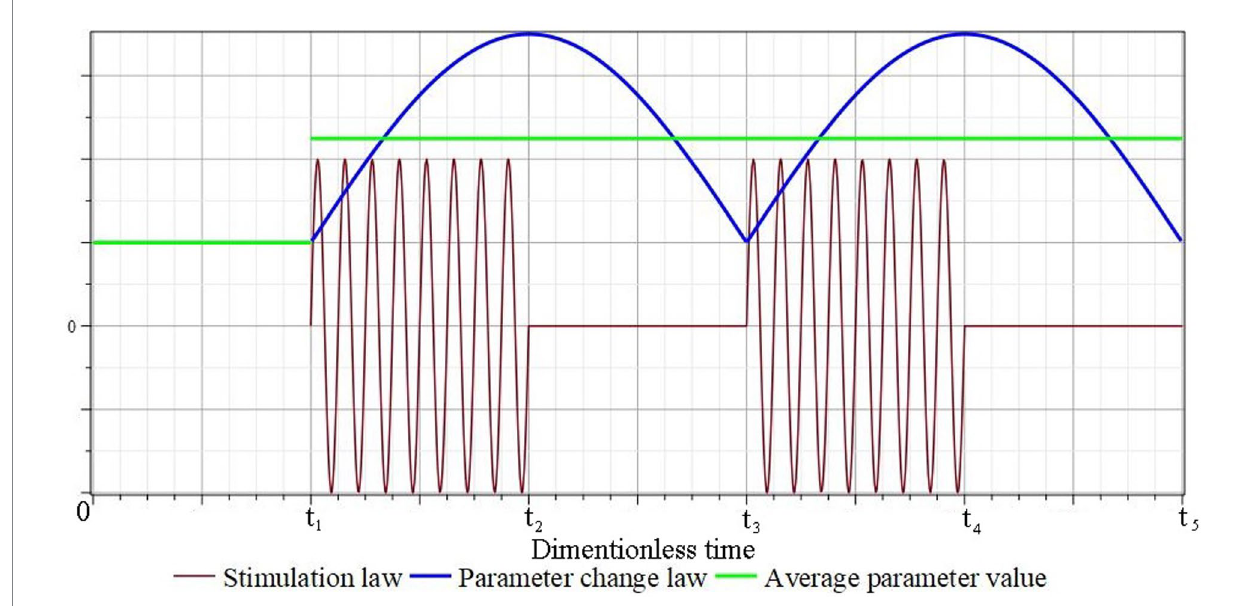
FIGURE 2 Schematic representation of the mathematical model conditional parameters corresponding to the law of periodic short-term tissue